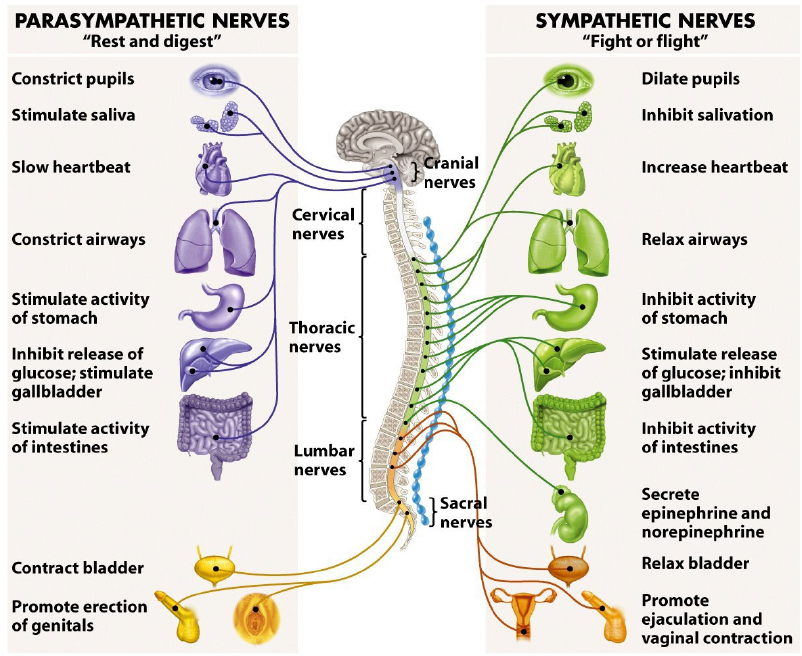
Figure 1. The human autonomic nervous system and its response stimuli [34].